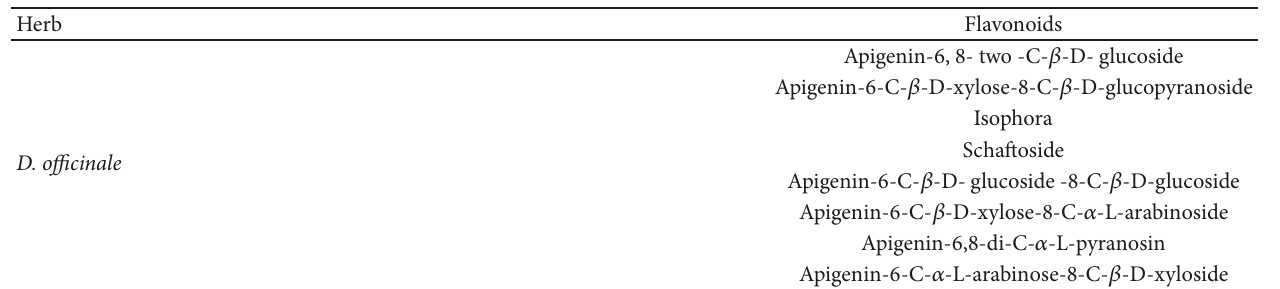
Table 8: Flavonoids in D.